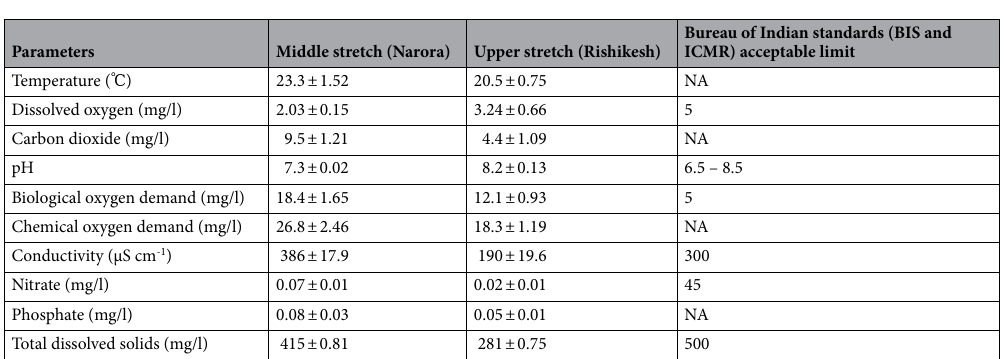
Table 1. Physico-chemical parameters of water samples collected from Narora and Rishikesh sites of river Ganga. ± Standard deviation. NA = Not available.